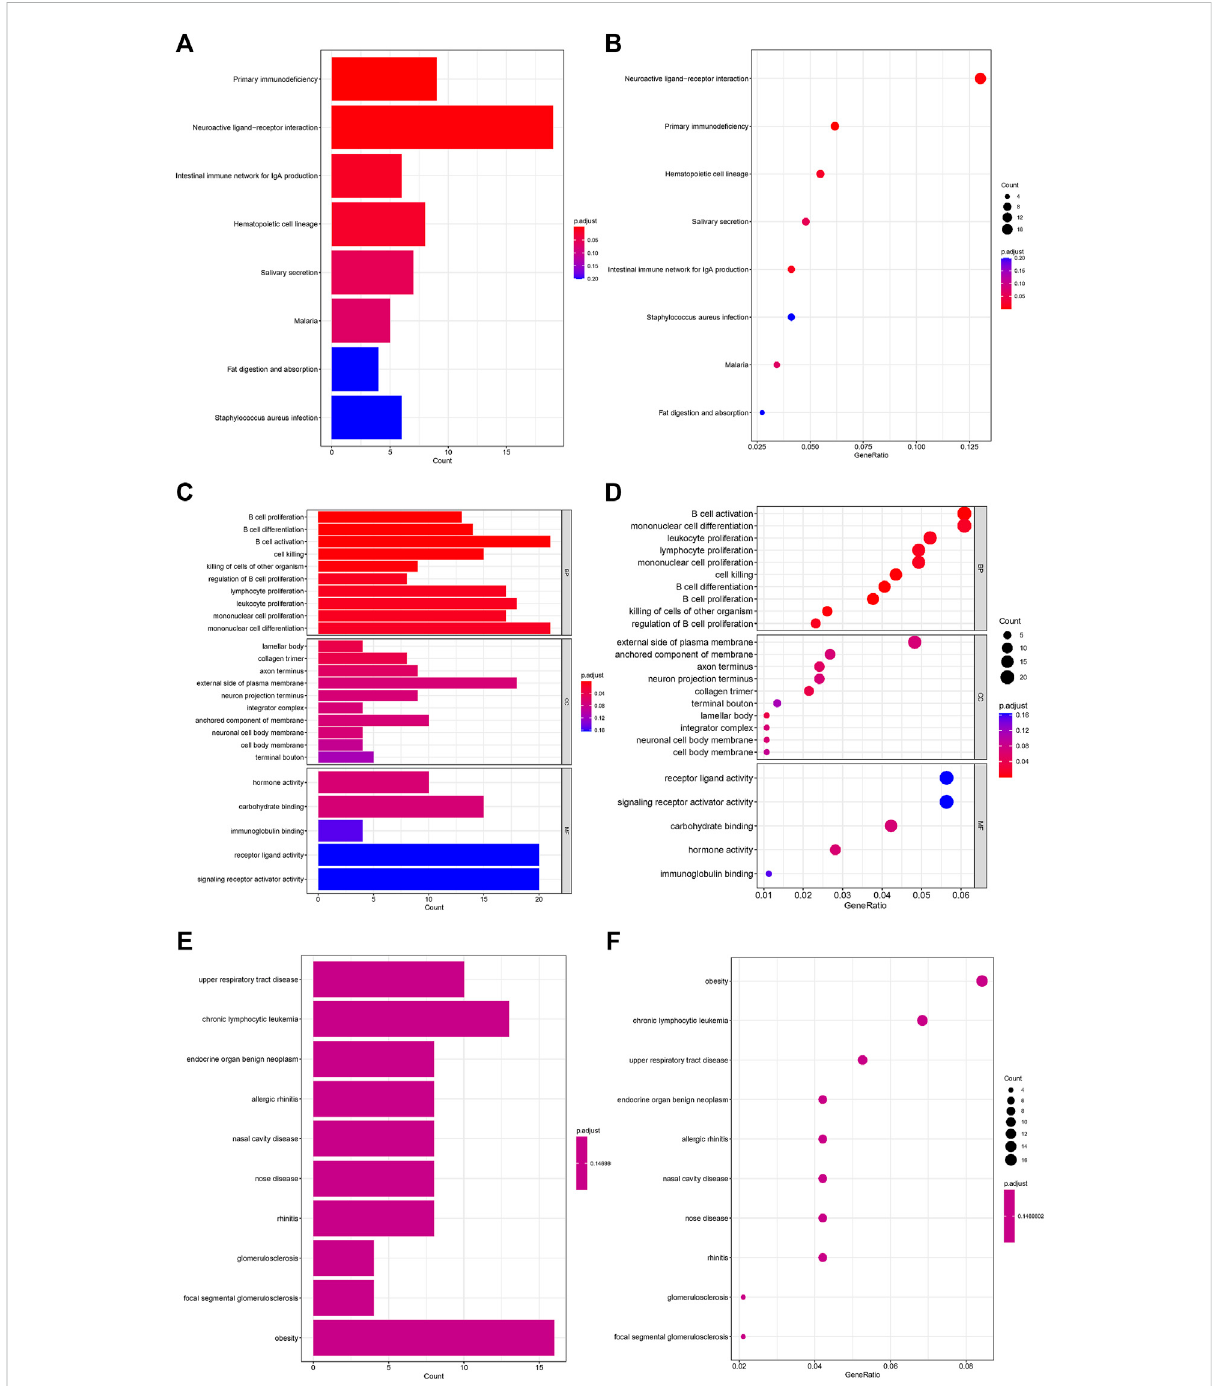
FIGURE 5 Functional enrichment analysis of intersection genes. (A,B) KEGG enrichment analysis. (C,D) GO enrichment analysis. (E,F) DO enrichment